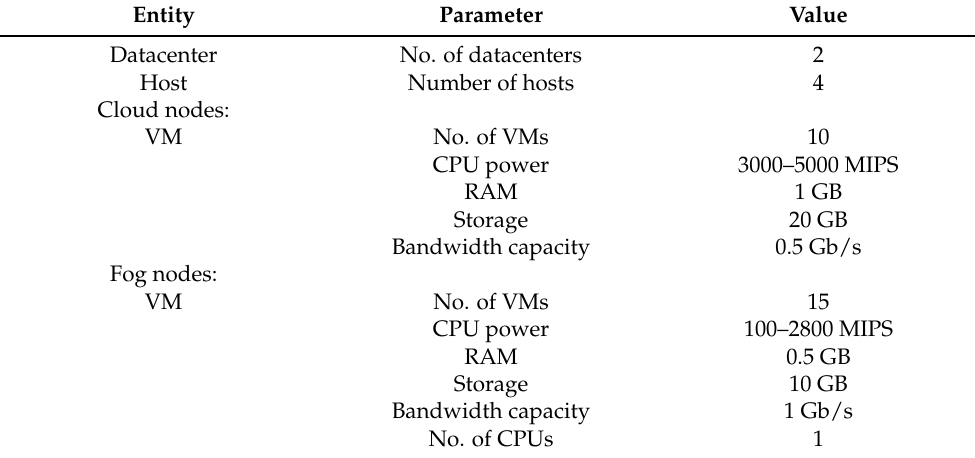
Table 1. Configuration of empirical